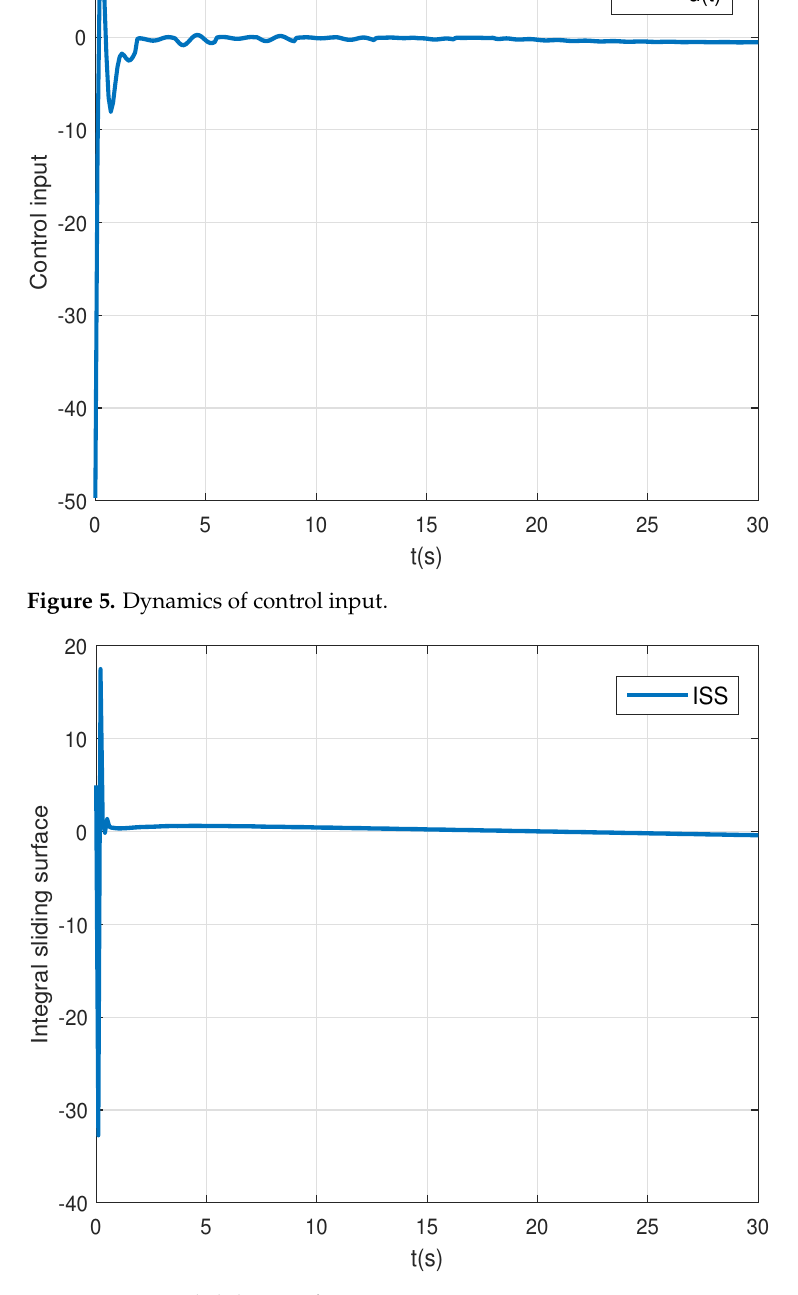
Figure 6. Integral sliding